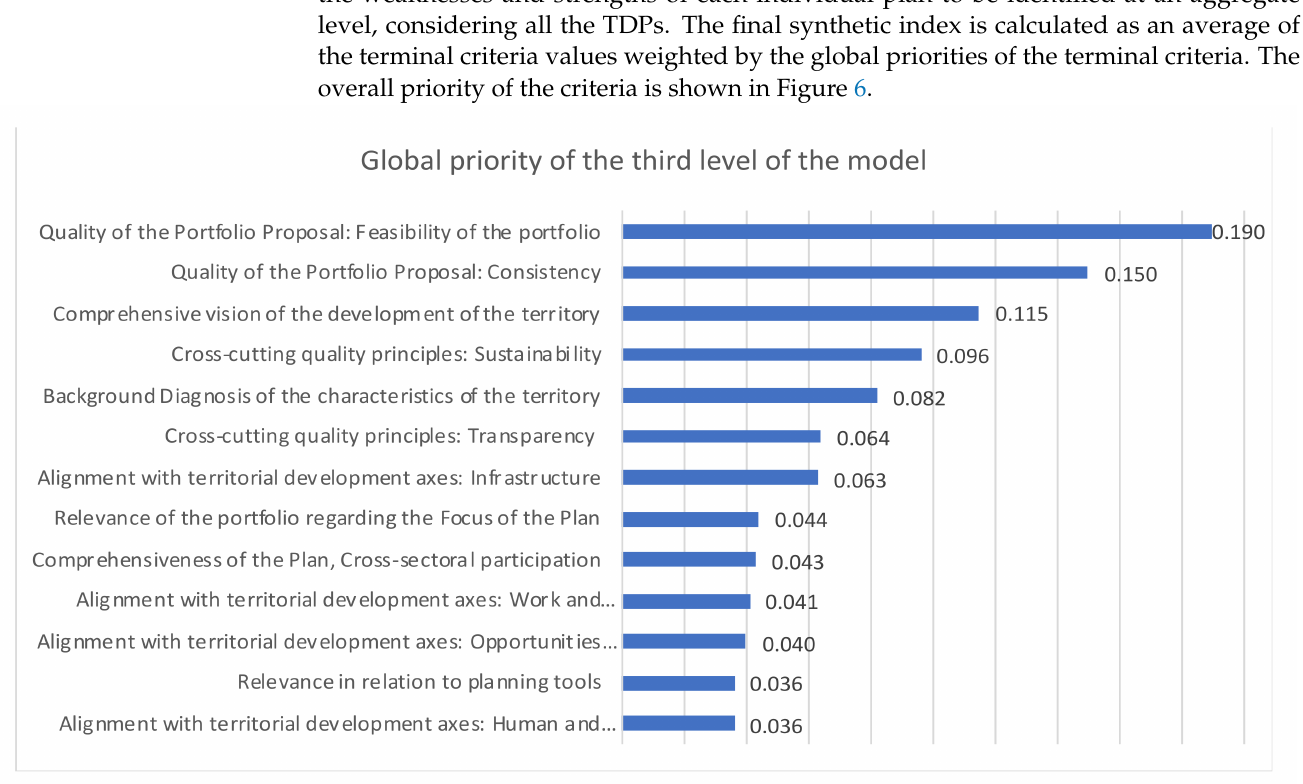
Figure 6. Overall priority of the